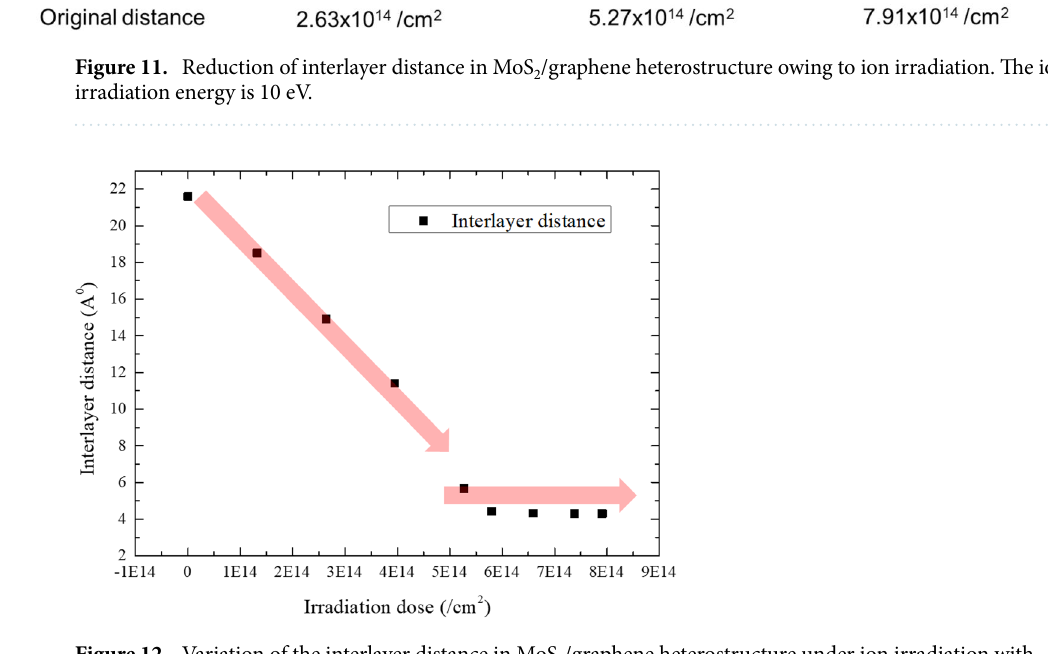
Figure 12. Variation of the interlayer distance in MoS 2 /graphene heterostructure under ion irradiation with different doses. The irradiation energy is 10